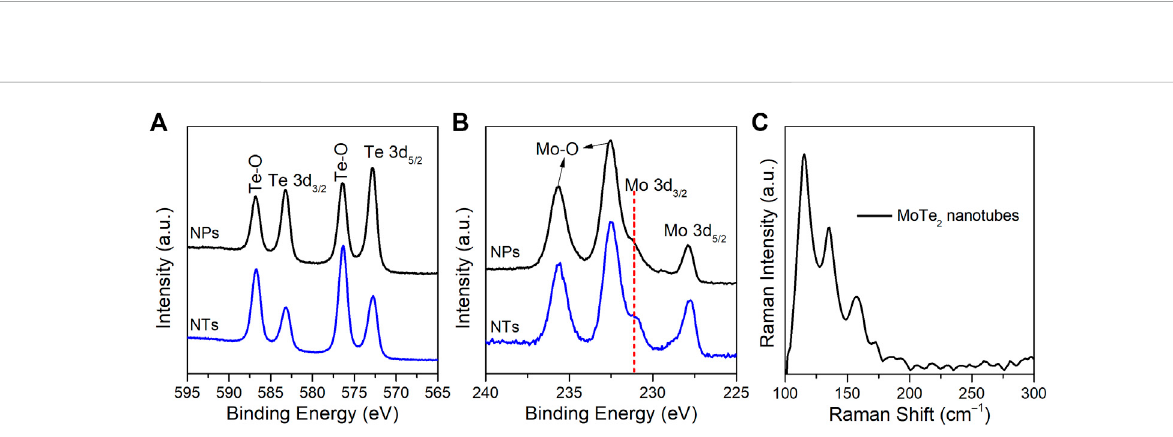
FIGURE 4 High-resolution XPS spectra of (A) Te 3d and (B) Mo 3d of MoTe 2 nanotubes (NTs) and MoTe 2 nanoparticles (NPs). (C) Raman spectrum of the as-synthesized MoTe 2